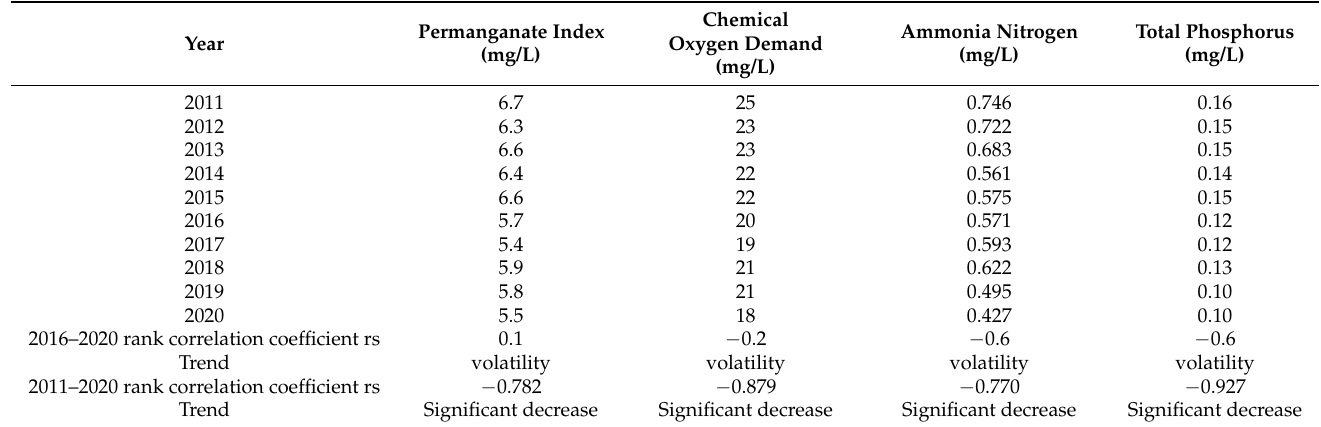
Table 3. The major pollutants in rivers of Heilongjiang Province from 2011 to